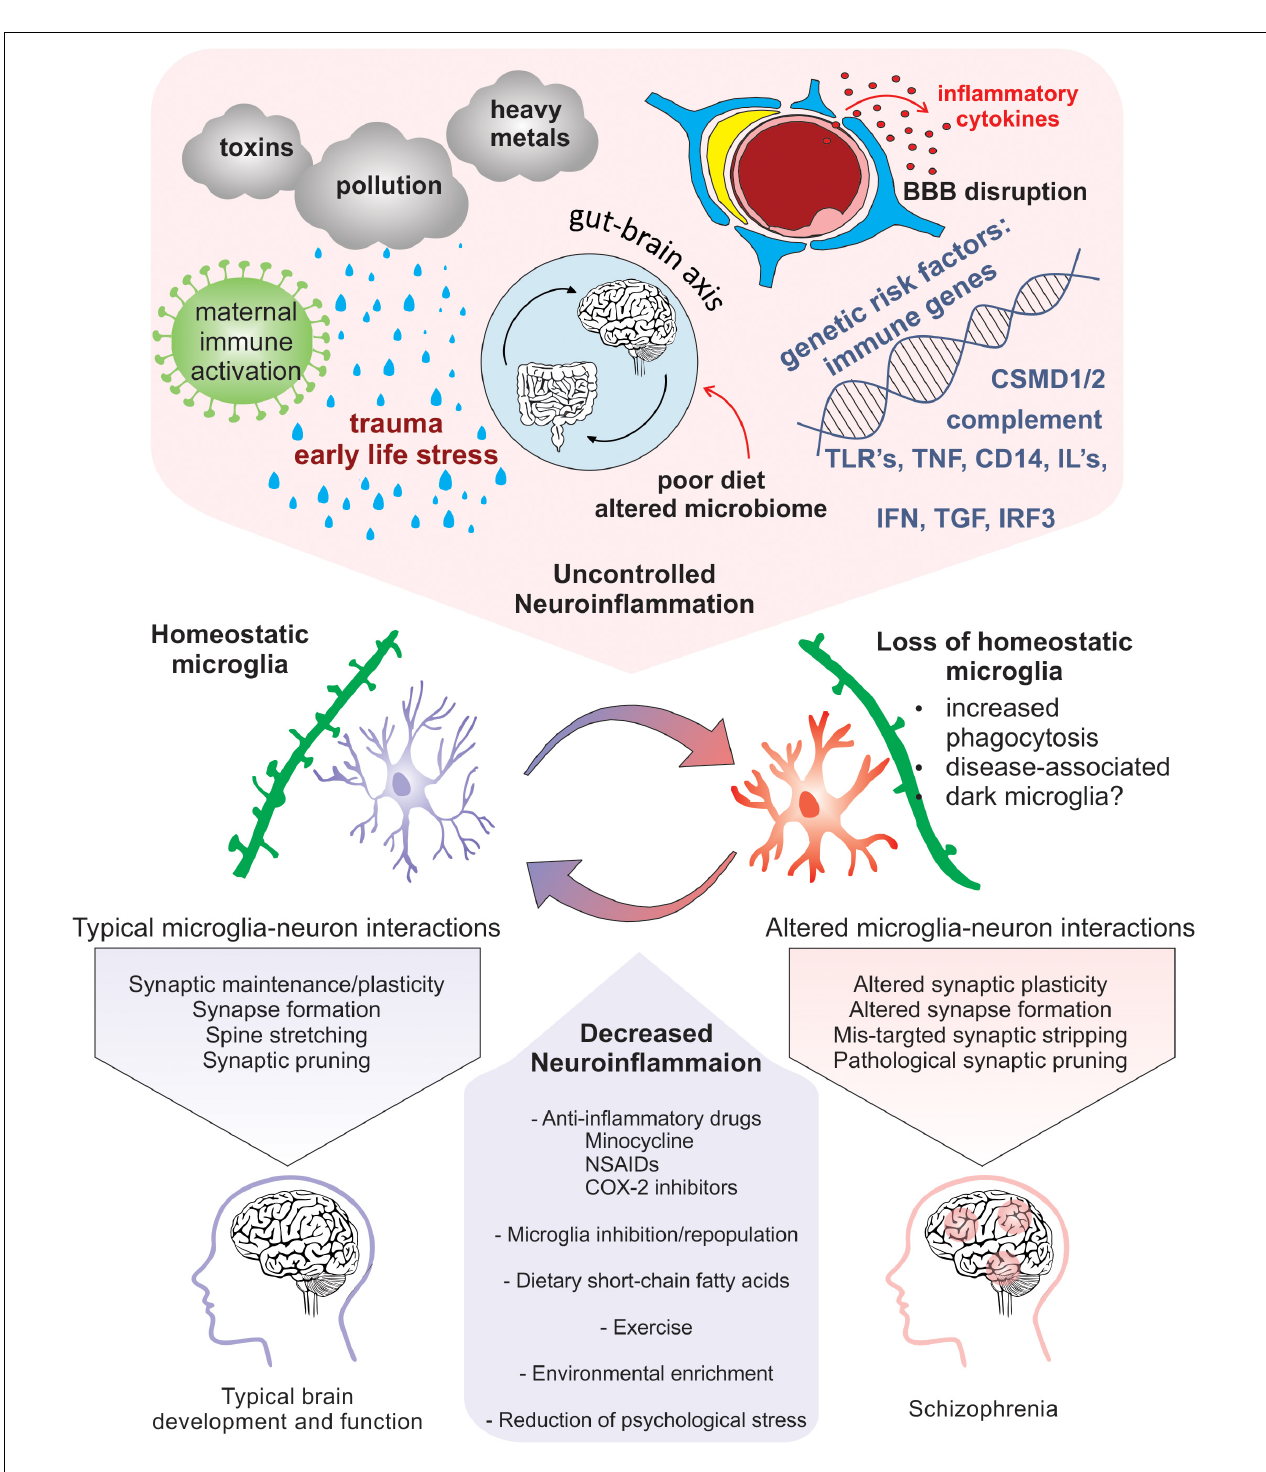
FIGURE 3 | Neuroinflammation-induced changes in microglia that are implicated in SCZ pathogenicity. Risk factors for SCZ that alter microglial function and enhance neuroinflammation include pollution, stress, nutrition induced gut-brain axis dysbiosis, viral infection, maternal immune activation, genetic predisposition, and cytokine secretion. Homeostatic microglia perform their immune sentinel role by interacting with neurons to guide circuit wiring during development. In an increased inflammatory milieu, loss of microglial homeostasis perturbs microglia-neuron interactions that may cause altered plasticity due to pathogenic synaptic formation, synaptic stripping, and pruning. Therapeutic approaches that promote homeostatic microglia through the reduction of neuroinflammation via anti-inflammatory drugs, microglial inhibition and repopulation, improved nutrition, environmental enrichment, and prevention of psychological stress could be potentially exploited to limit exacerbation of